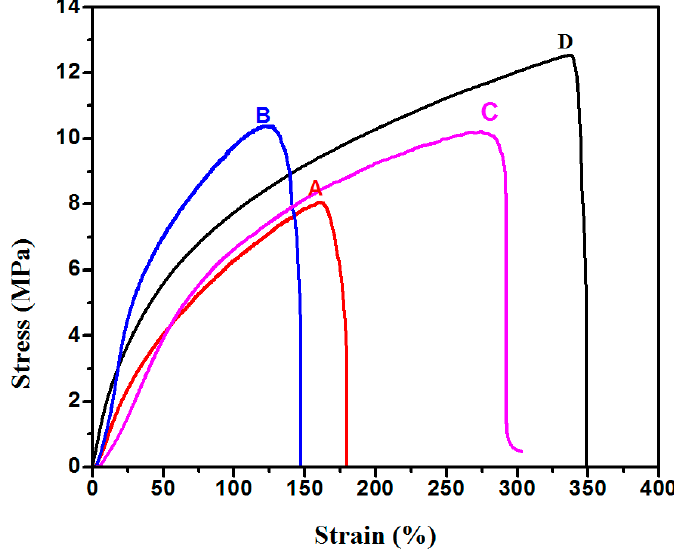
Figure 2. Stress-strain curves of the electrospun mats of P1 ( A in red), P2 ( B in blue), and P1 annealed ( C in magenta) and P2 annealed ( D in black) at 47 °C.